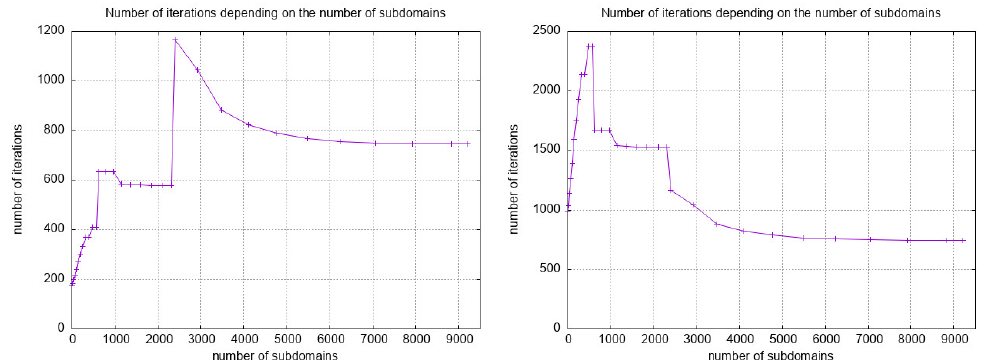
Figure 6. Number of iterations depending on the number of subdomains: damping parameter associated with the color ( left ) and constant damping parameter ( right